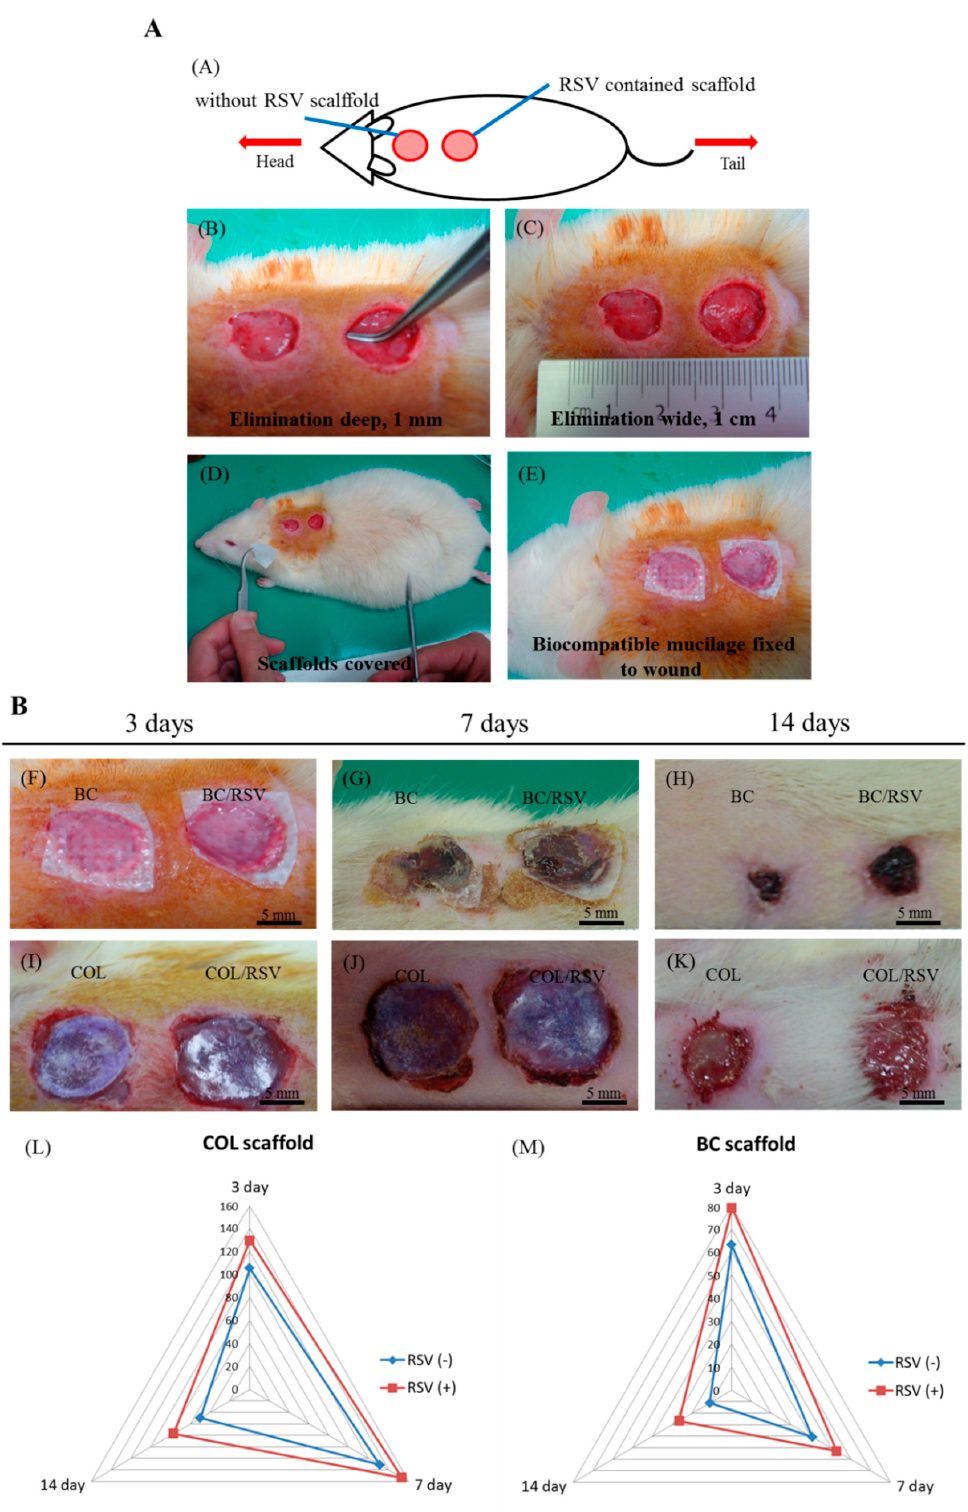
Figure 8. Effect of scaffolds on dermal wound healing. ( A ) Skin defects induced on the back of a rat and filled with scaffolds; ( B ) wound contraction observed in each scaffold group on days 3, 7, and 14 after injury. [( L ),( M )] Semi-quantitatively measure the wound area of the epidermal defect in each material group.